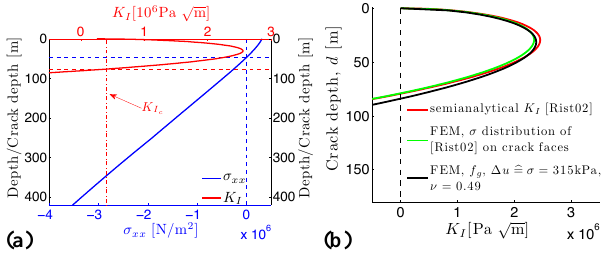
Fig. 2. (a) Resulting horizontal stress and stress intensity factors. (b) Comparison of the numerical model to results of Rist et al. Fig. 2. (a) Difference between numerical simulation and analytical result for different mesh sizes. ( ∆ x = element edge length at crack tip). (b) Discretization in entire geometry with focus at crack tip.